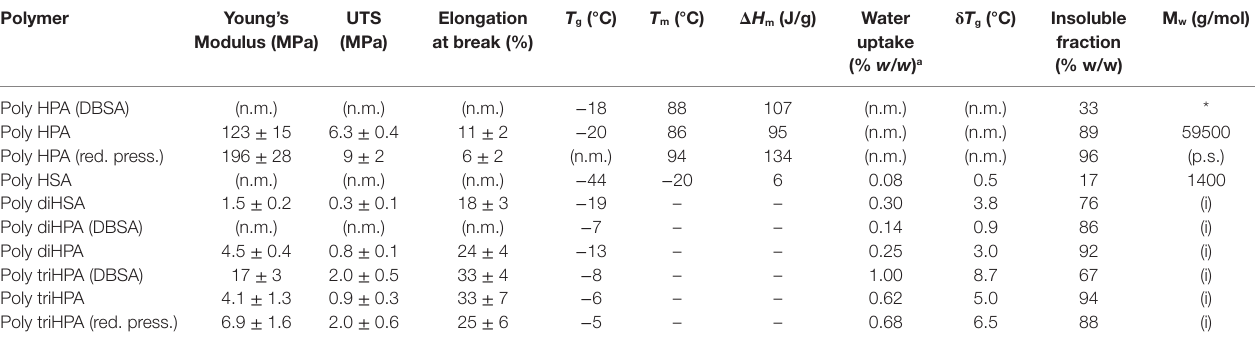
TaBle 2 | Physical parameters of polyhydroxyesters obtained.